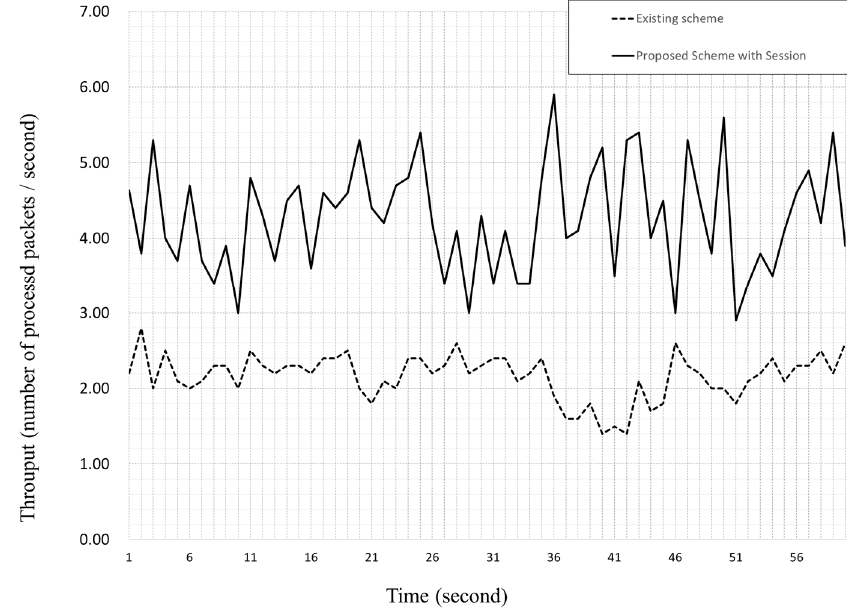
Figure 23. Throughput over simulation time.